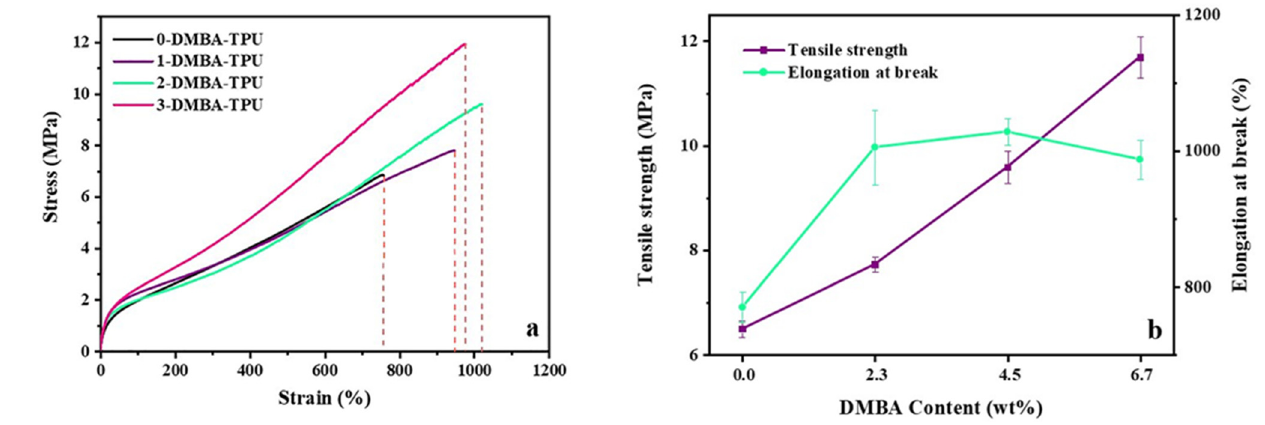
Figure 4. ( a ) Tensile stress–strain curves, ( b ) mechanical performances of TPU with different DMBA content.